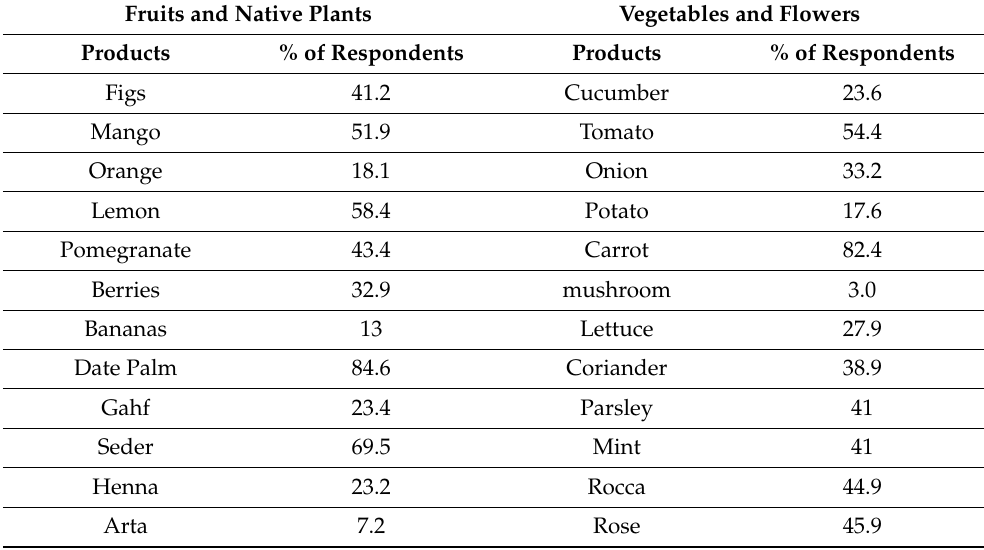
Table 2. The Kind of Crops Produced in the Home Gardens in Al Ain. Fruits and Native Plants Vegetables and